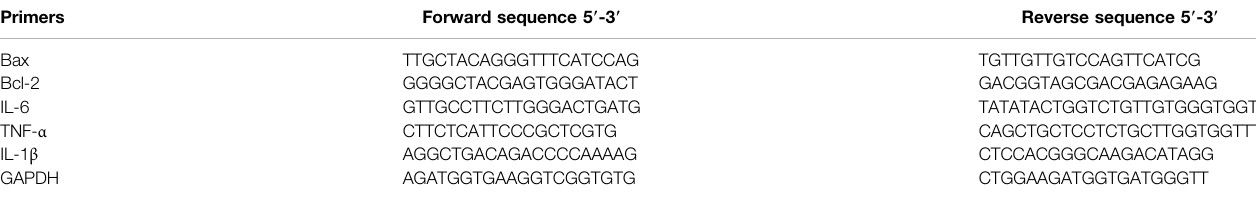
TABLE 1 | Primers used for RT-qPCR